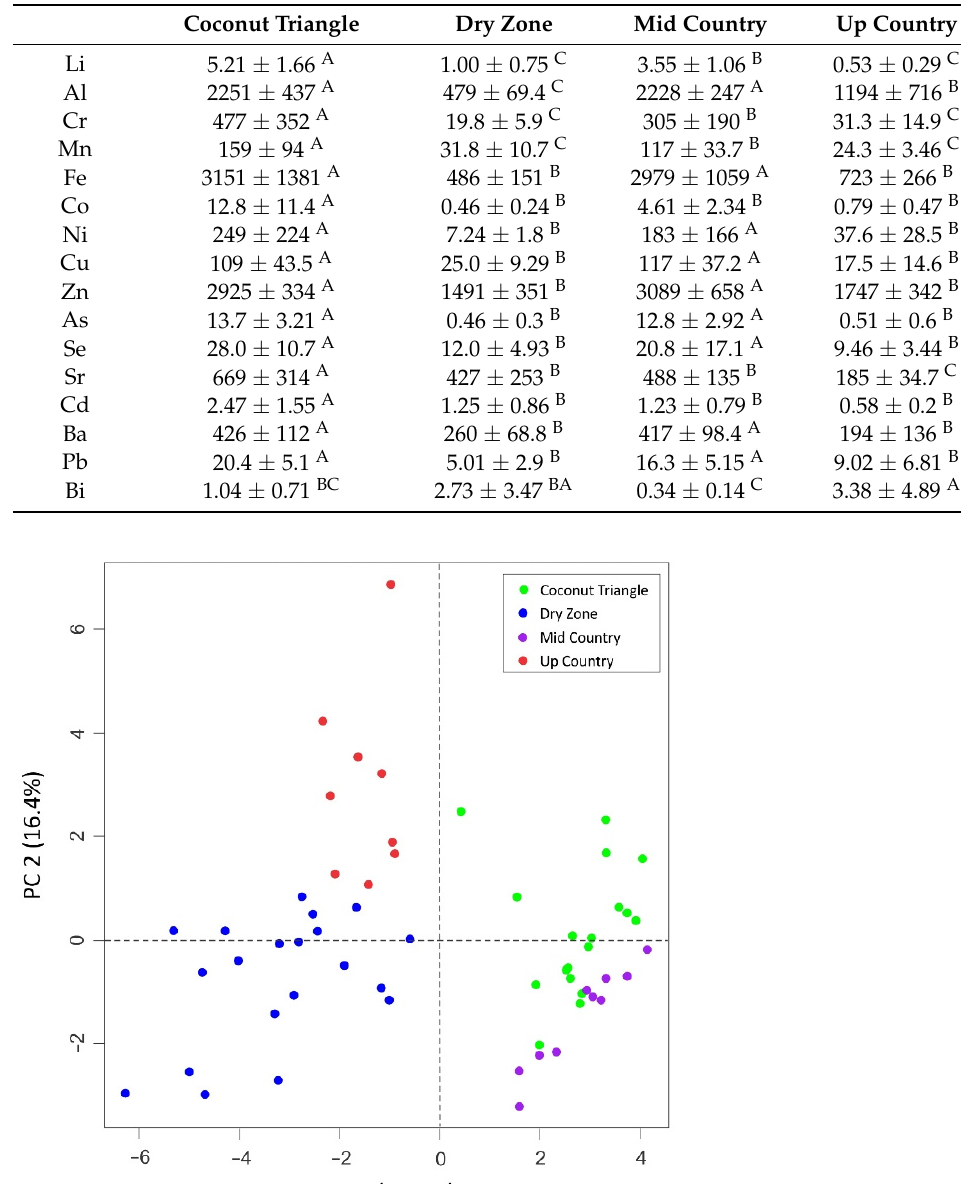
Figure 7. LDA of milk samples with both selected trace elements and stable isotope ratios to dis- criminate four agroclimatic zones.